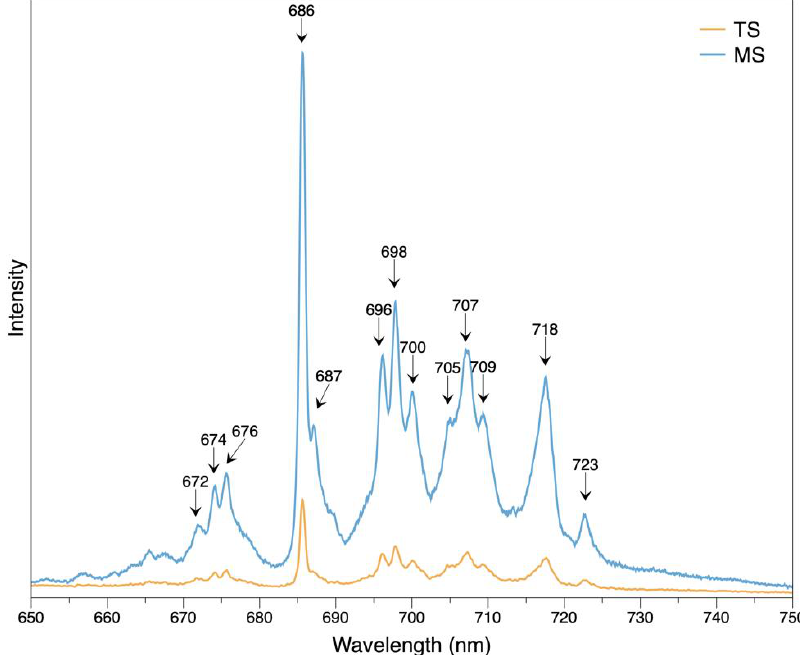
Figure 8. PL spectra of spinels from Tanzania and Myanmar.